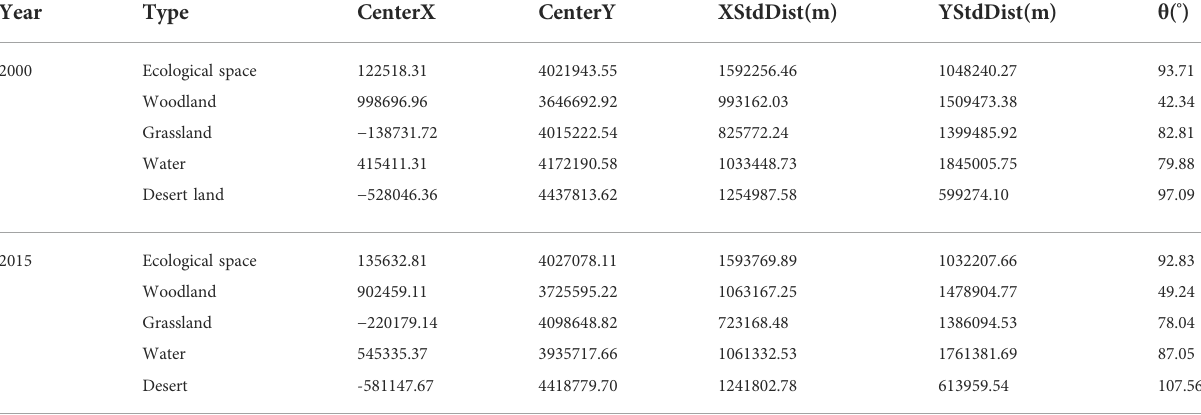
TABLE 6 SDE parameters of ecological space types from 2000 to 2015.